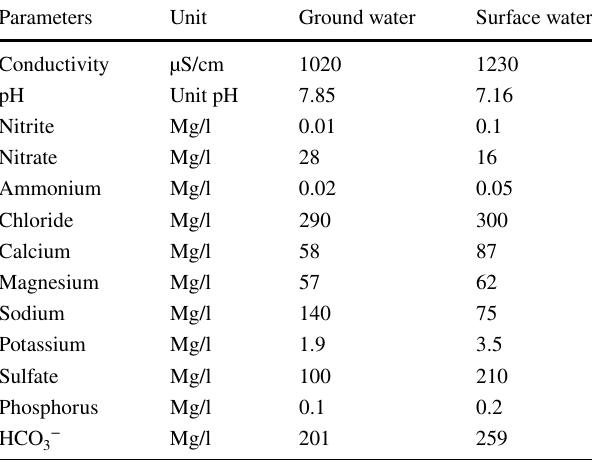
Fig. 7 Satisfaction with quality Table 2 Physicochemical quality of the surface and groundwater of Bechar